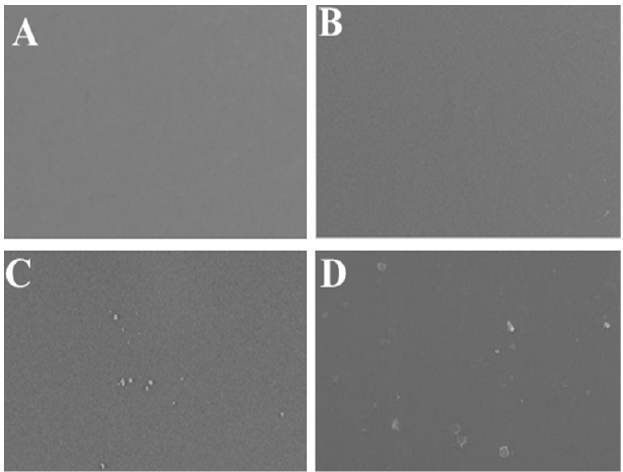
Figure 2. Active films’ SEM images, where ( A ) Control (Ch-0% EPPE), ( B ) Ch-1% EPPE, ( C ) Ch-3% EPPE, and ( D ) Ch-5%EPPE.